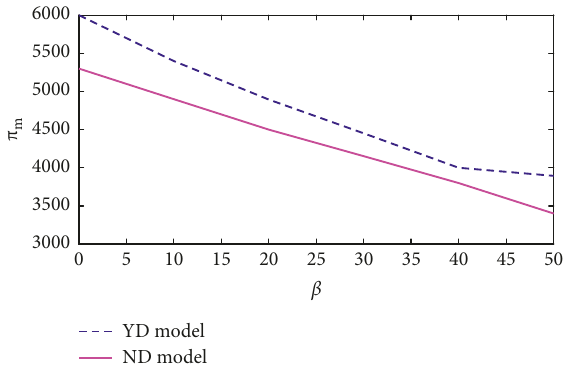
Figure 2: The impact of β on the manufacturer’s profit under the ND model and YD model.